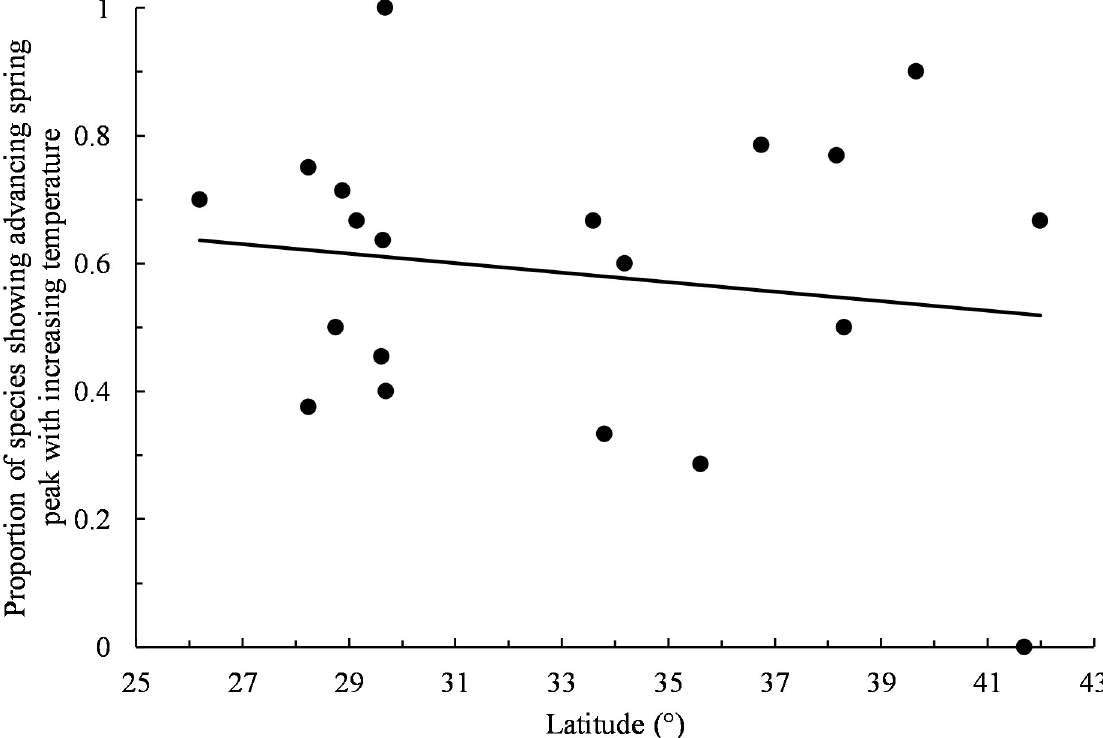
Fig 4. Proportion of species showing advancing spring peak with increasing temperature by refuge latitude. Only non-zero slopes were included. Trend line obtained by least squares linear regression.